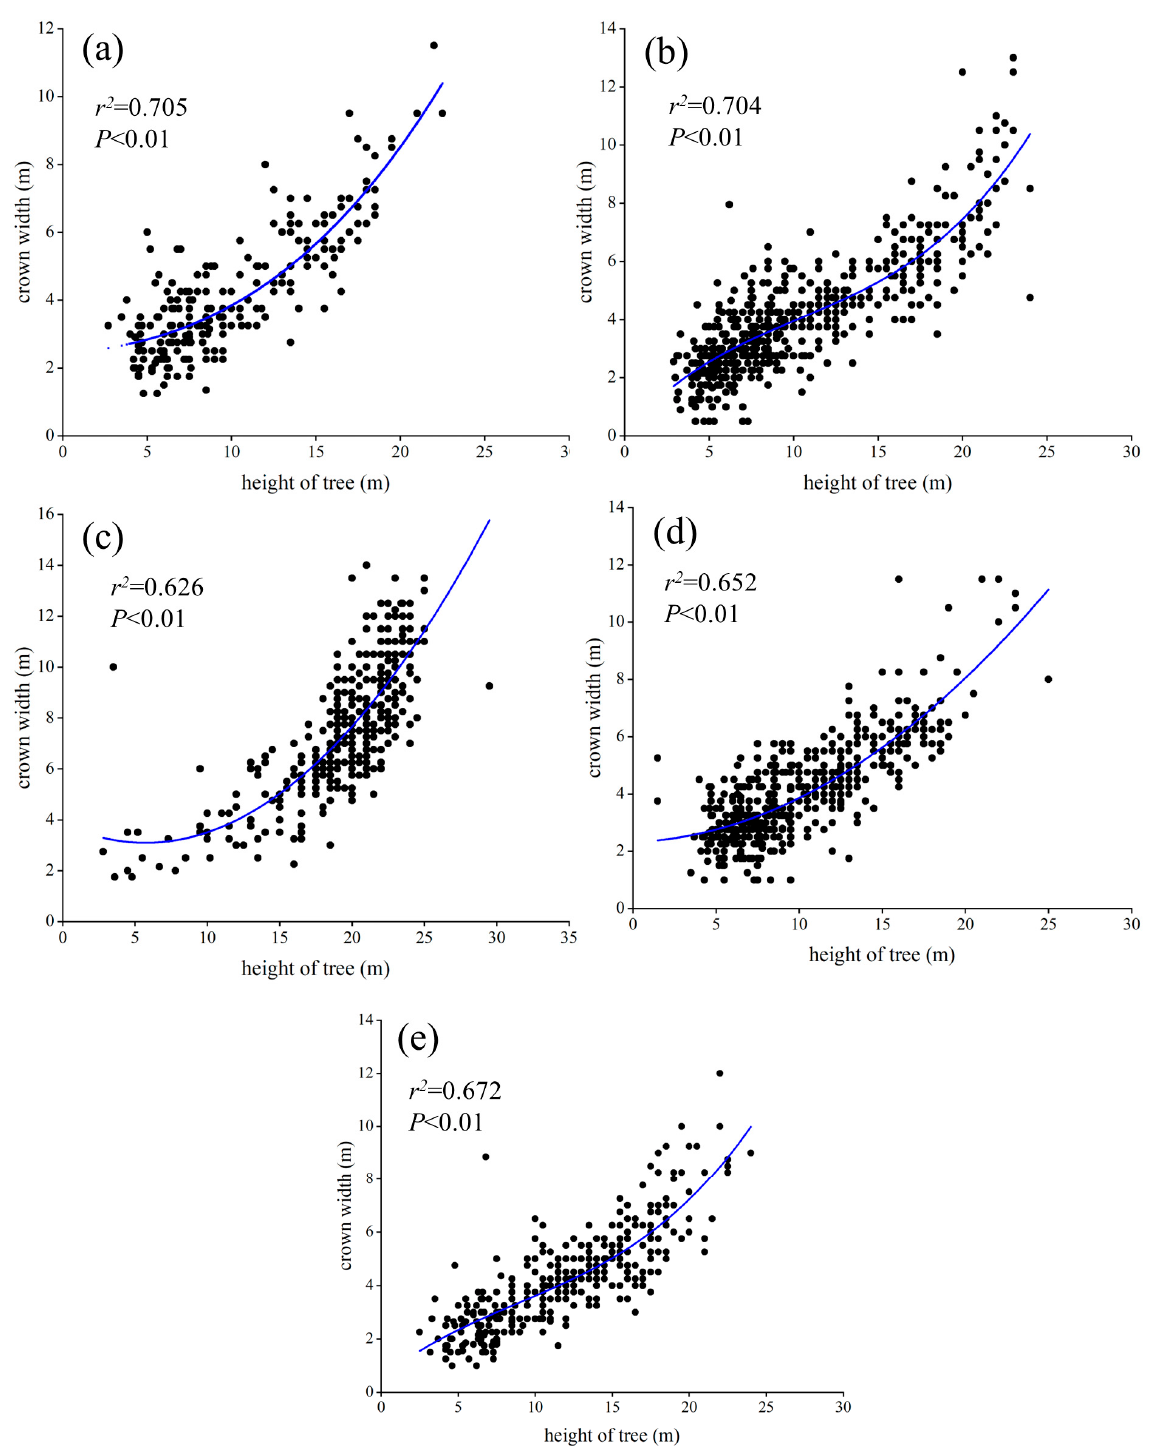
Figure 5. Scatterplot of tree height and crown width. The lines in figures ( a – e ) represent the optimal curve fitting between the height of the tree and crown width of the main dominant species. ( a ) Acer mandshuricum ; ( b ) Ulmus japonica ; ( c ) Juglans mandshurica ; ( d ) Acer mono ; ( e ) Tilia amurensis